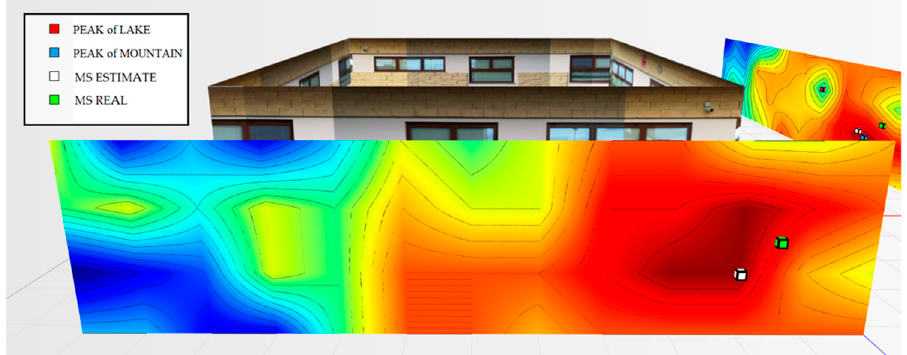
Figure 24. Power levels for wall 1 relative to the terminal located in the room on the left at 1.5 m.